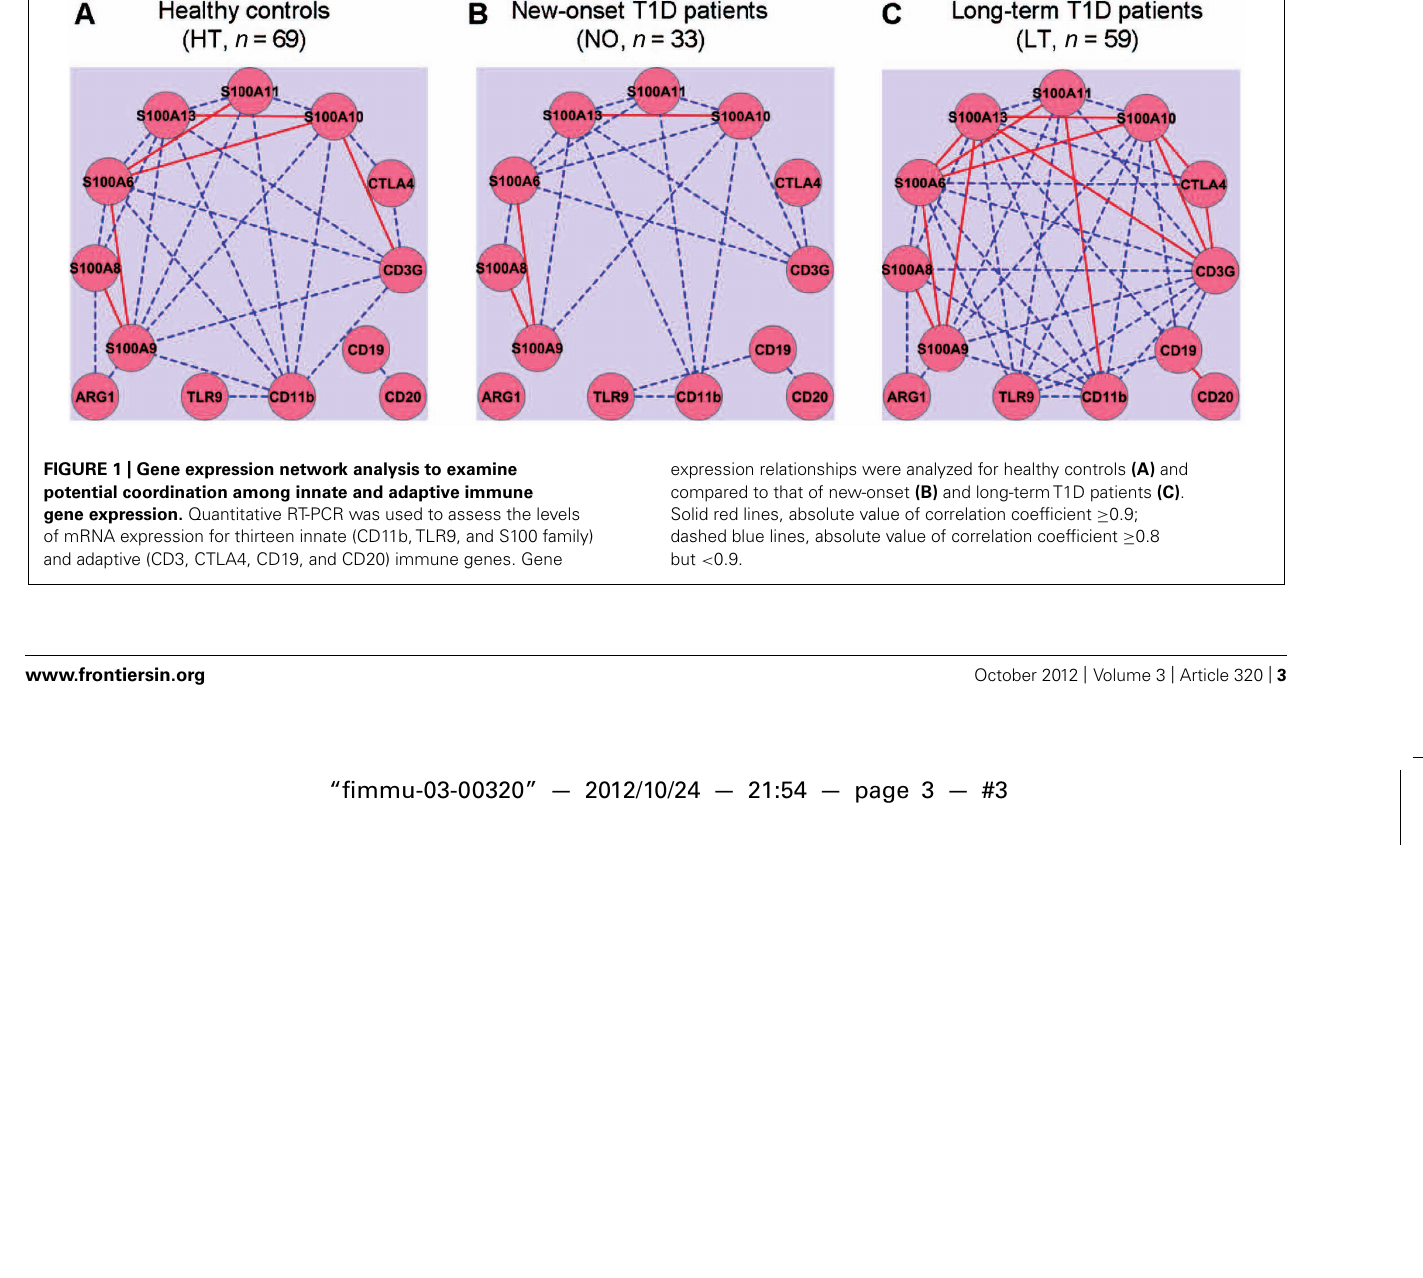
expression relationships were analyzed for healthy controls (A) and compared to that of new-onset (B) and long-termT1D patients (C) . Solid red lines, absolute value of correlation coefficient ≥ 0.9; dashed blue lines, absolute value of correlation coefficient ≥ 0.8 but <